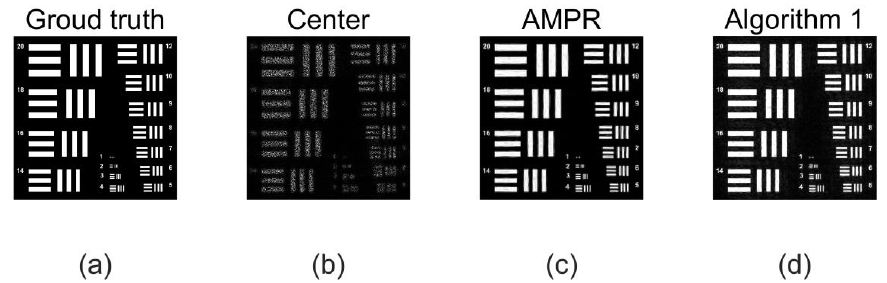
Figure 7. Experimental results using pixel uniform sub-sampling ( a ) Ground truth: we simulate imaging a 64 × 64 mm resolution target 50 m away using the sensor with a pixel pitch of 2 µ m. ( b ) Center image: Structural Similarity Index (SSIM) = 0.2866. The target is observed using a